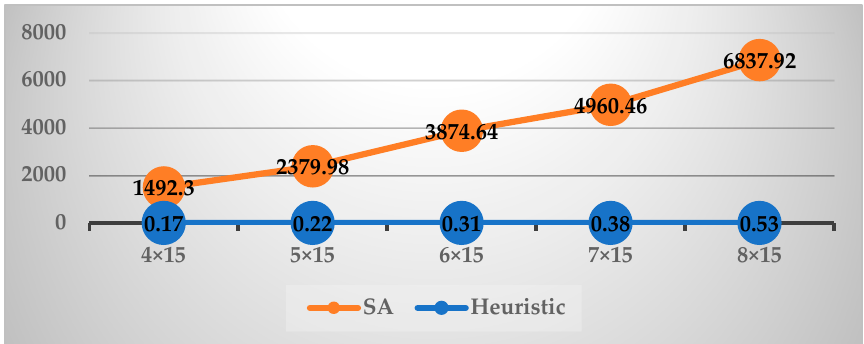
Figure 7. Time-comparison diagram of the SA and heuristic algorithms for different test problems (10 ORs).